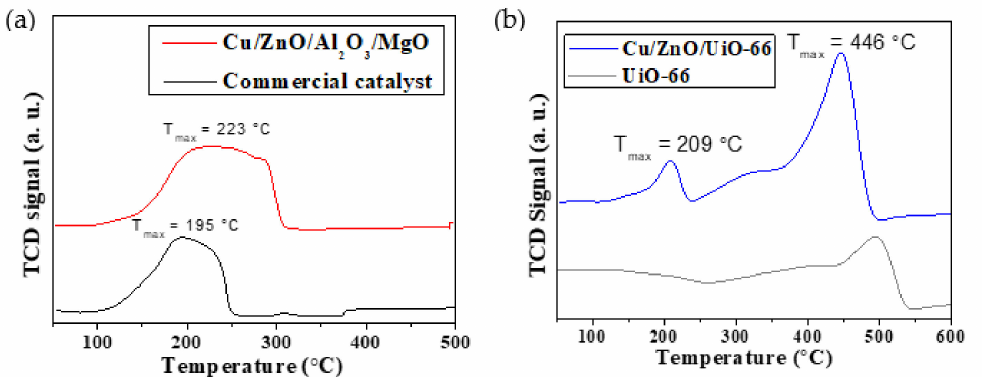
Figure 5. H 2 -TPR profiles of the prepared catalysts: ( a ) Commercial and Cu/ZnO/Al 2 O 3 /MgO catalysts; ( b ) UiO-66 and